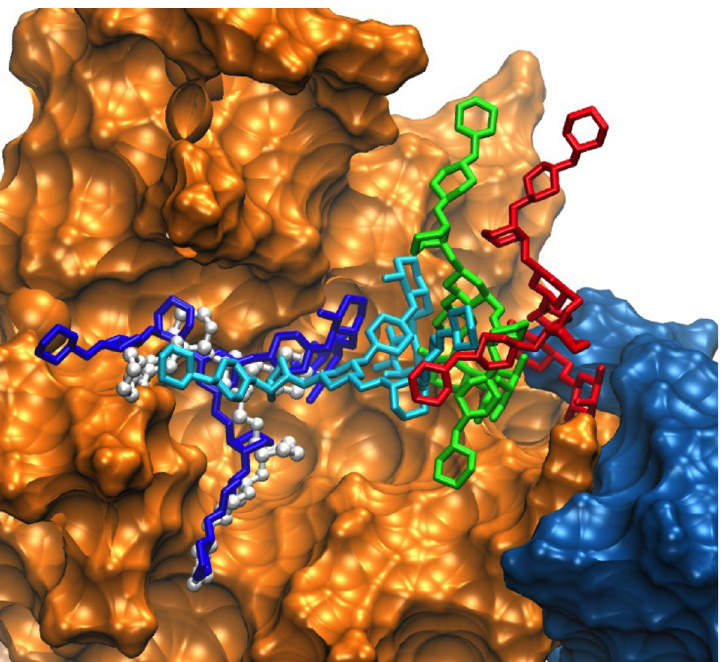
Fig 6. Transfer of the glycan from CBM (blue surface) to GH (orange surface) from model C simulation 2. Different locations of the glycan in sticks are color highlighted. For the glycan red corresponds to its initial location between the GH and CBM, green corresponds to an intermediate (900 ns) state, cyan corresponds to a second intermediate (1624 ns) state and dark blue corresponds to the final state (3296 ns) with the glycan in the GH active site. Crystallographic conformation of the bound glycan is shown in white ball and stick representation. For visualization, the Fc protein chains were removed.